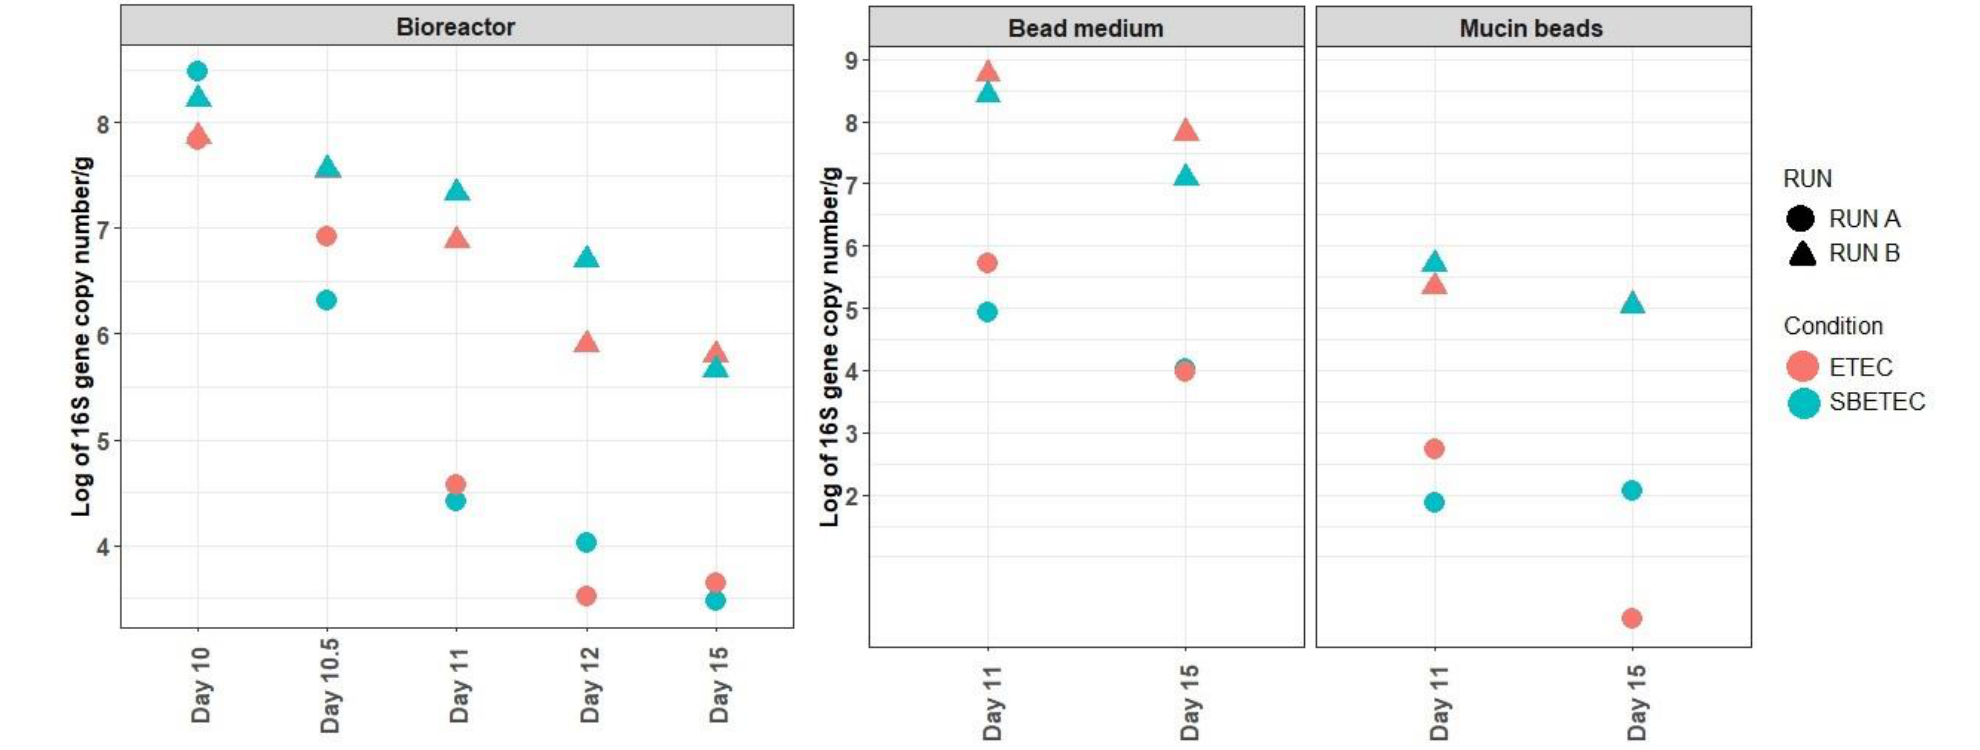
Figure 3. Quantification of the LT enterotoxin gene in the MPigut-IVM during ETEC and SBETEC conditions. Each value is an average of two to three technical replicates.